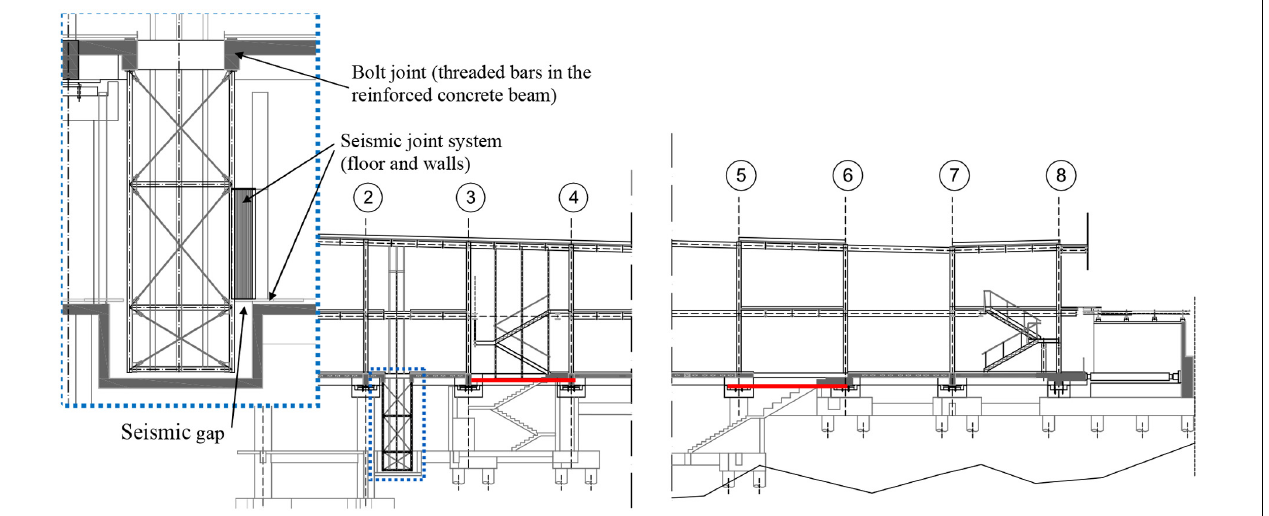
FIGURE 5 | Sections of the building (the red line highlights the seismic cut of staircases whereas the blue dotted area highlights the steel frame of the hanged